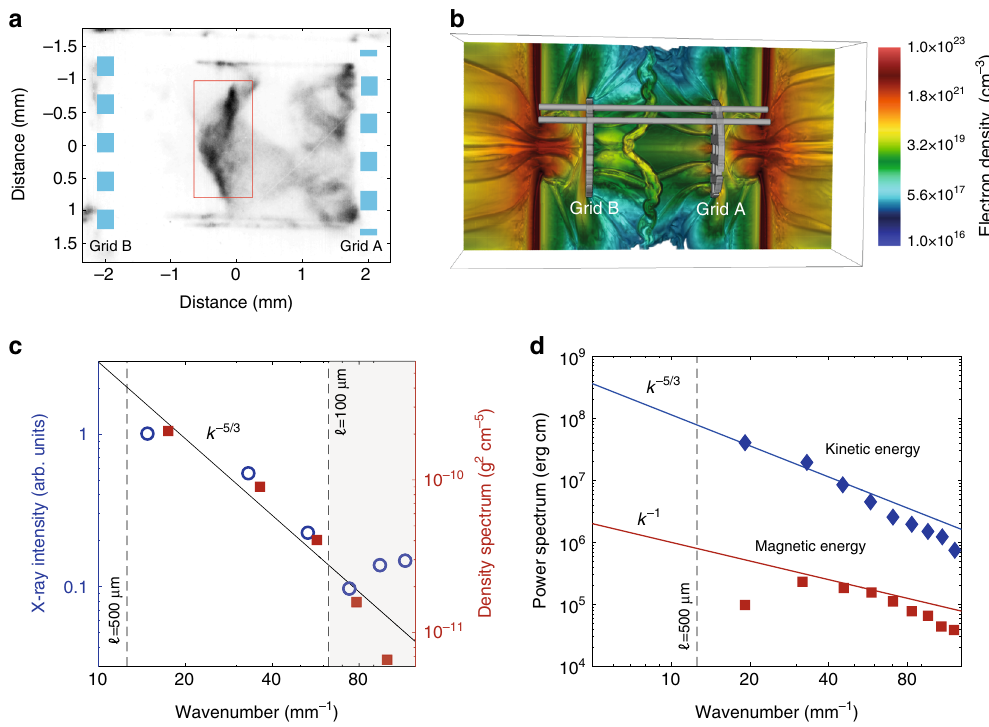
Fig. 2 Characterization of the plasma turbulence. a X-ray pinhole image of the colliding fl ows at t = 35 ns after the laser drive, using the 5 ns pulse pro fi le. The image was recorded onto a framing camera with ~1 ns gate width and fi ltered with 0.5 μ m C 2 H 4 and 0.15 μ m Al. The pinhole diameter is 50 μ m. b Rendering of the electron density from three-dimensional FLASH simulations at t = 35 ns. c The open blue circles give the power spectrum of the X-ray emission from the collision region, de fi ned by the rectangular region shown in panel a . The power spectrum has been fi ltered to remove edge effects and image defects. Details of this procedure are given in Supplementary Methods. The shaded region at high wavenumbers is dominated by noise. The spectrum of the density fl uctuations, as obtained from FLASH simulations in the turbulent region, is shown with red squares. d Blue diamonds: power spectrum of the kinetic energy from FLASH simulations. Red squares: power spectrum of magnetic energy from FLASH simulations. The simulated magnetic energy spectrum is considerably shallower than the Kolmogorov-like kinetic energy spectrum, as predicted by ref. 23 and other studies in the Pm < 1 regime (see